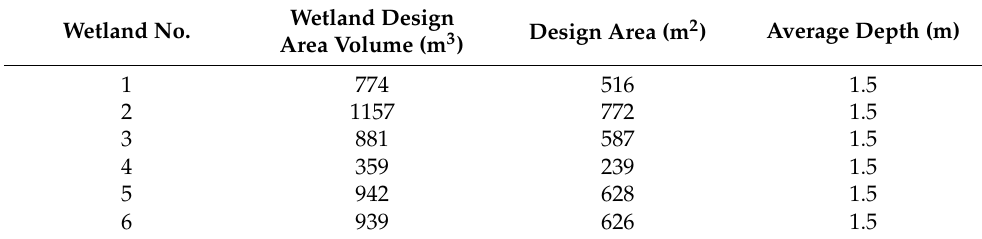
Table A2. Wetland parameters of the termina detention and retention